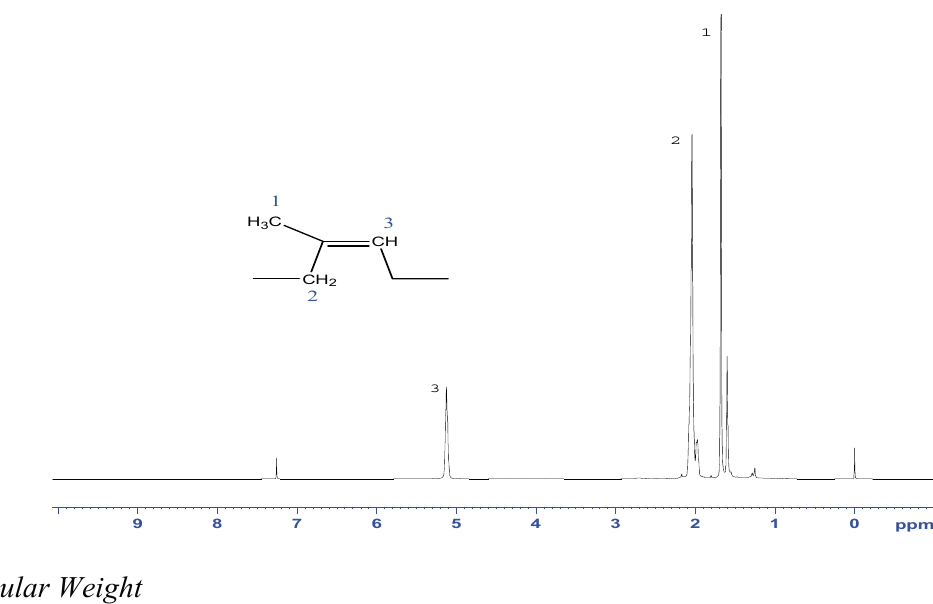
Figure 9. 1 H NMR spectrum of LNR prepared in neutral medium.